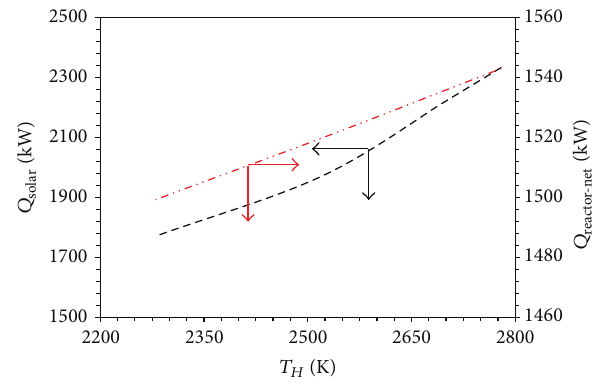
𝑇 𝑄 and (b) 𝑄 𝐻 on (a) solar reactor-net